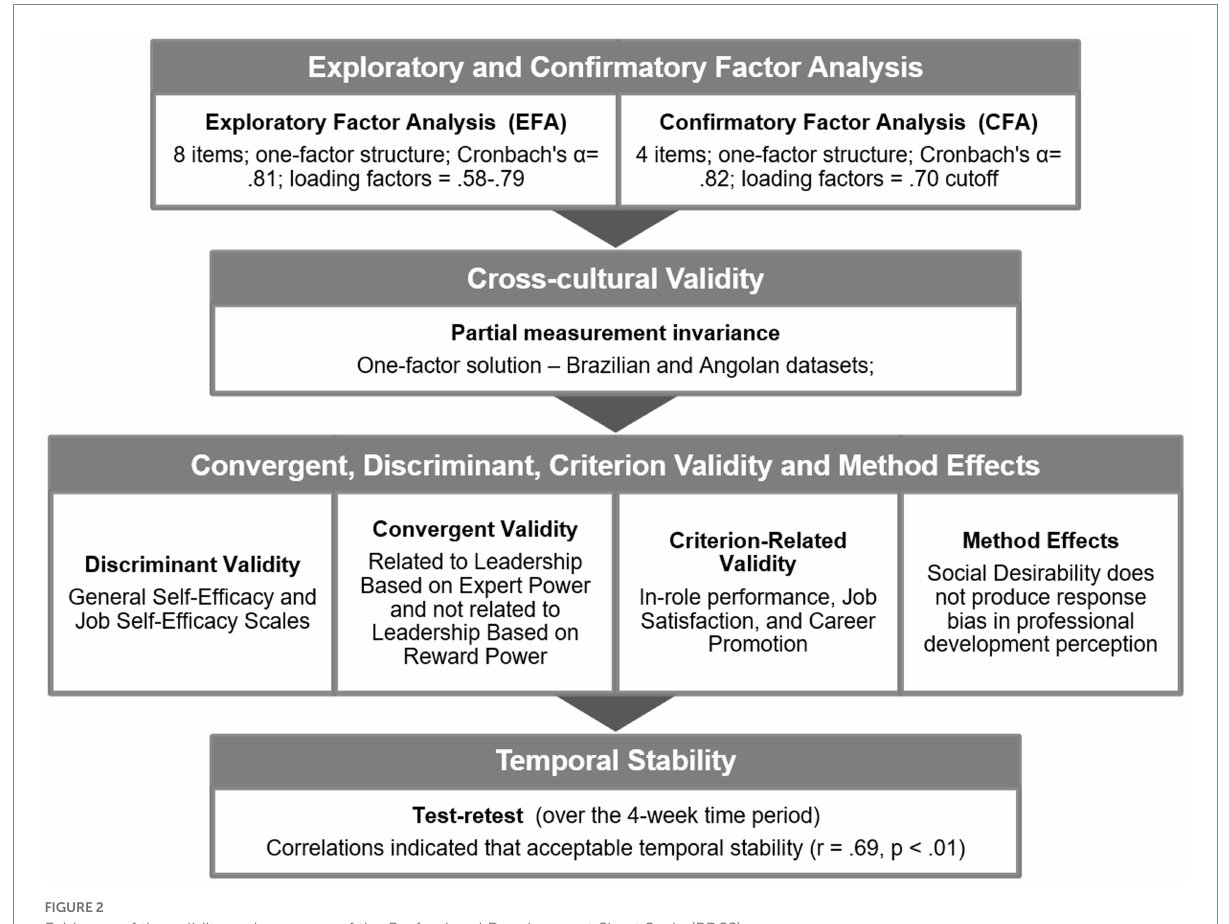
FIGURE 2 Evidence of the validity and accuracy of the Professional Development Short Scale